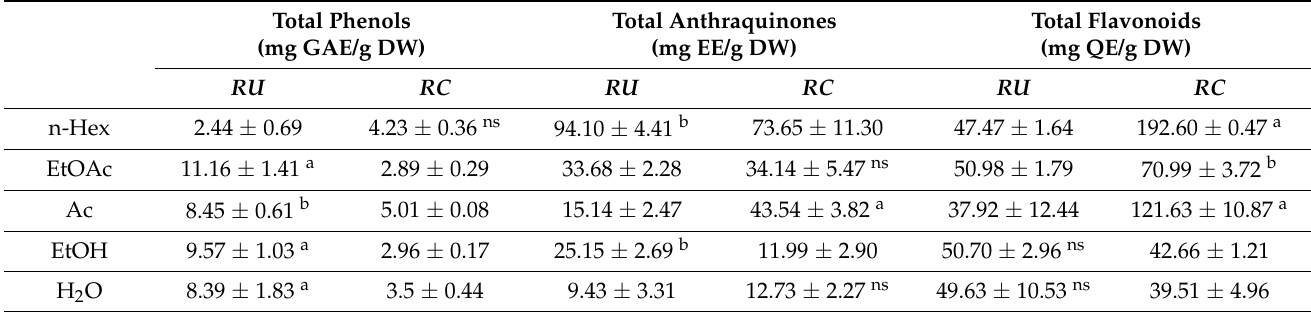
Table 1. Phytochemical contents of RU and RC extracts in different solvents.